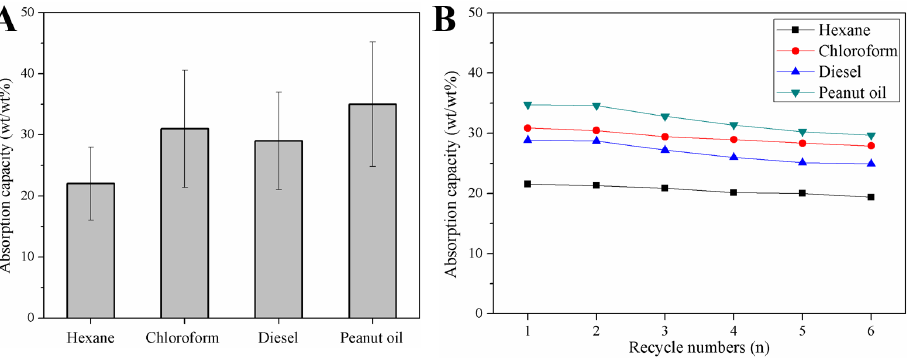
Figure 8. Absorption capacities ( A ) and recyclability ( B ) of the m-AS/Kaolin@MS.